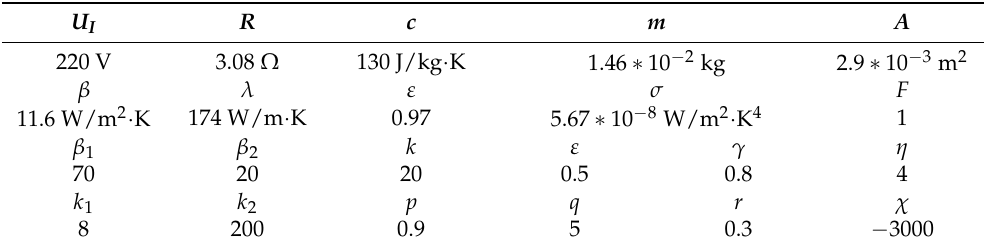
Table 7. All parameters of TSTQLs system and controllers. U I R c